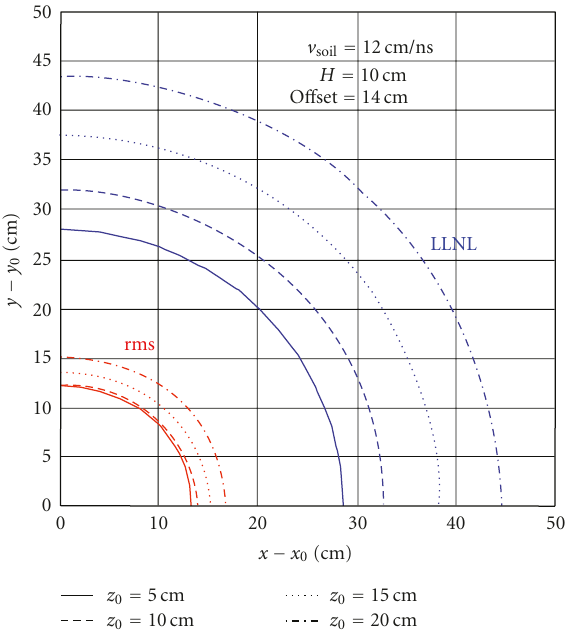
Figure 3: Migration aperture with the one-step approach for the rms and the LLNL approximations at four di ff erent target depths. The antenna-medium distance is 10cm; the radar wave velocity into the medium is 12cm/ns; the TX-RX distance is 14 cm with the azimuth oriented in the y -direction. A small distortion of the circular shape is observed on the migration aperture as a result of the TX-RX